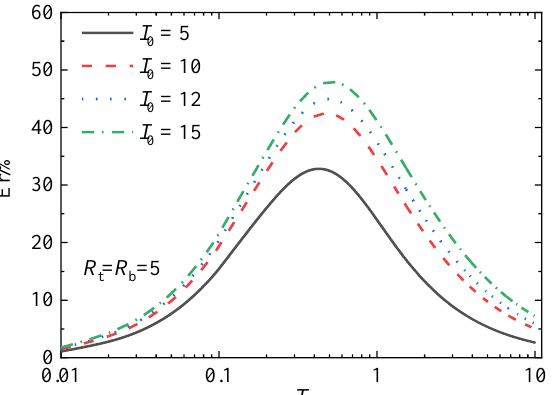
Figure 14. Deviations in the consolidation degree between Darcy’s law and non-Darcian flow under a double-side impeded drainage boundary with larger I 0 .